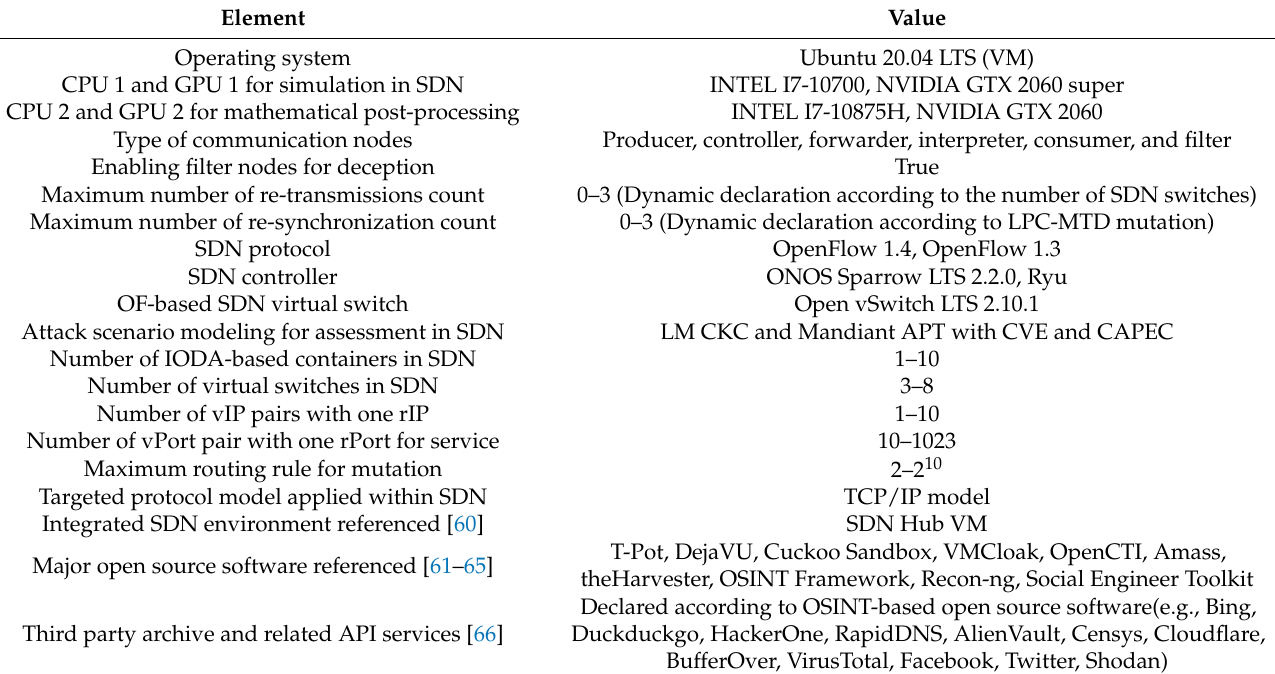
Table A5. Configuration of experimental elements in SDN-based testbeds and MATLAB-based post-processing.